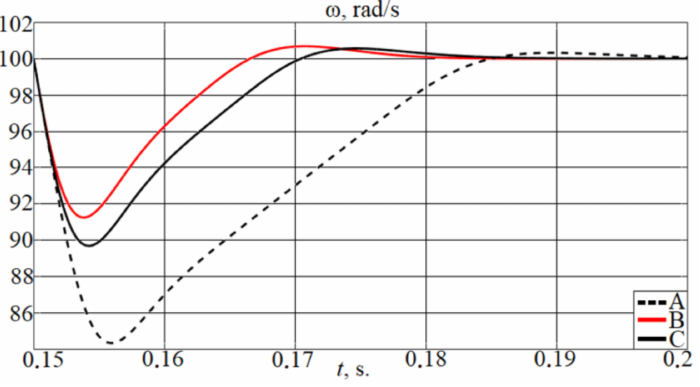
Figure 5. Comparison of motor speed curves when τ e (cid:54) = 0 and ˆ K ref ( 0 ) − K ref = 0. The ideal value of τ e and the obtained transient of its estimation ˆ u ad are shown in Figure 6.